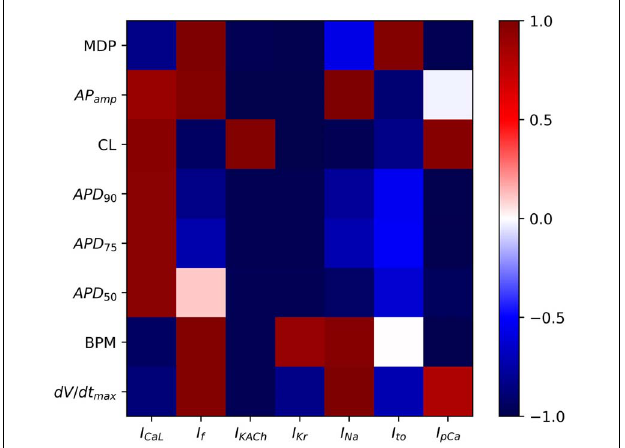
FIGURE 9 | Sensitivity analysis of model showing color-coded correlation coefficients corresponding to the ionic current variations and their effects on the AP